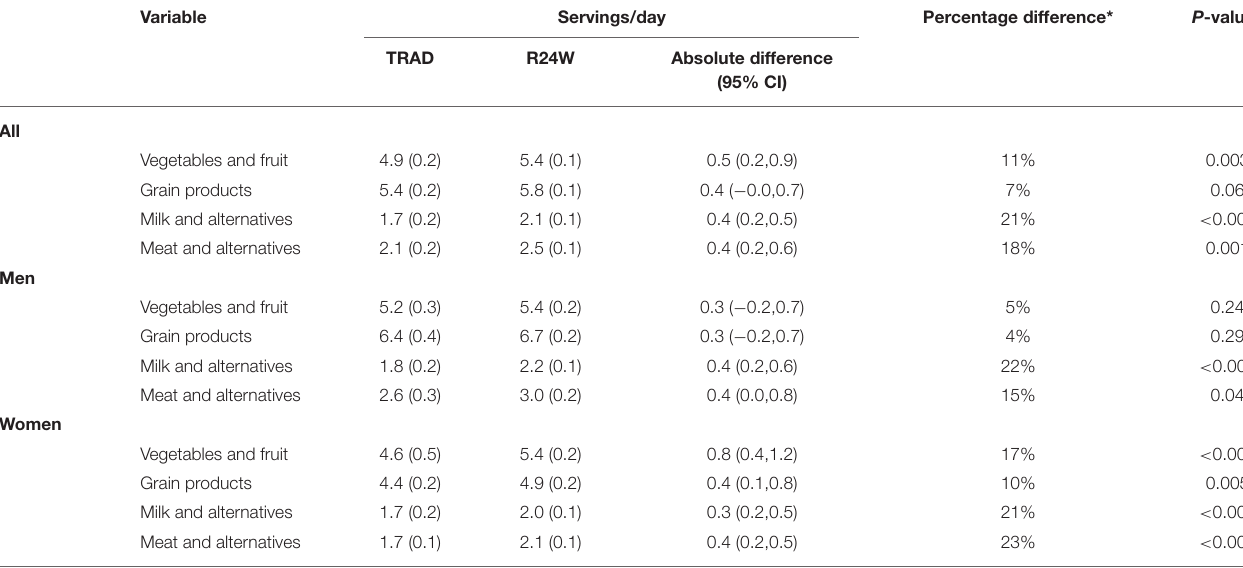
TABLE 2 | Mean Canada’s Food Guide-2007 servings using an interview-administered 24-h recall (TRAD) and a web-based 24-h recall (R24W) in population-based samples of French-speaking adults from Quebec, Canada. Variable